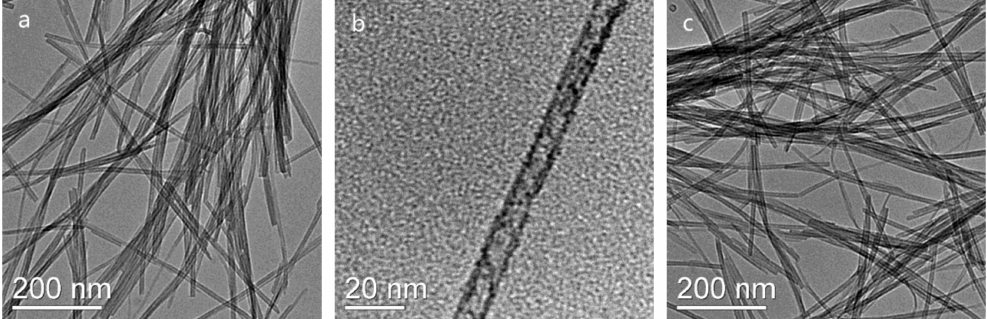
Figure 1. TEM images of ( a , b ) CeO 2 _NW, and ( c ) CeO 2 _NW_500.